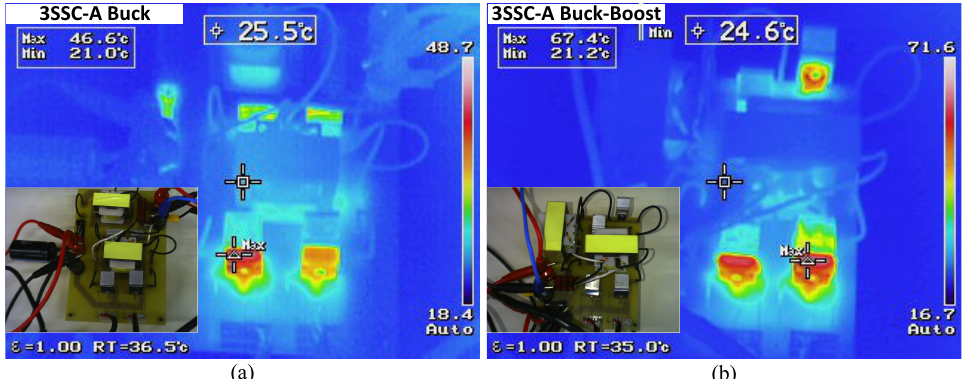
Figure 15. Thermal image of the converters at full load: ( a ) 3SSC-A-based buck; ( b ) 3SSC-A-based